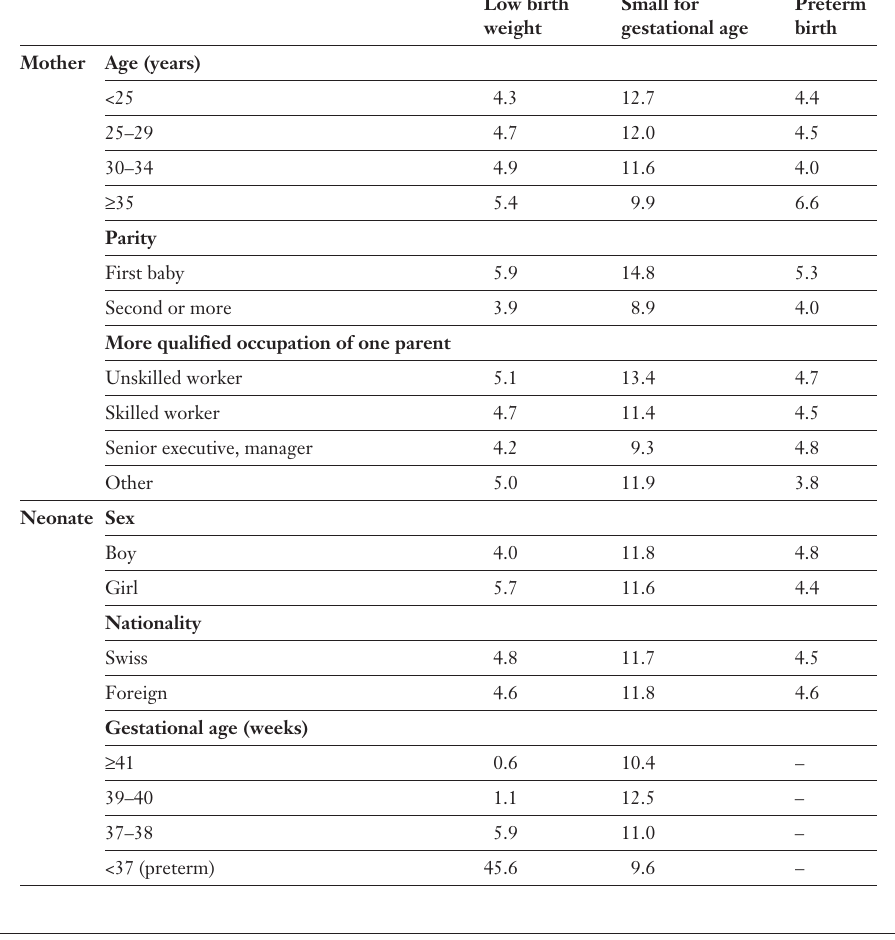
Proportions (%) of infants with low birth weight, small weight for gesta- tional age and born prematurely across categories of se- lected variables.